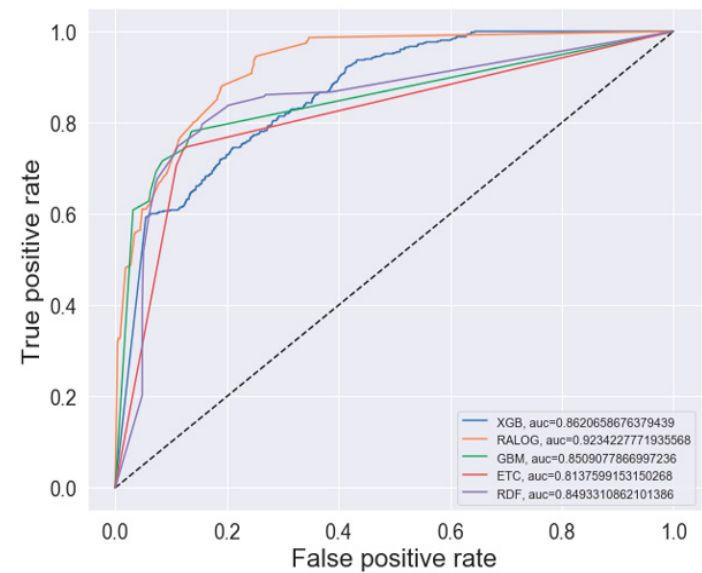
Figure 7. Receiver operating curve (ROC) curve before recursive feature elimination (RFE). Algorithms 2020 , 13 , x FOR PEER REVIEW